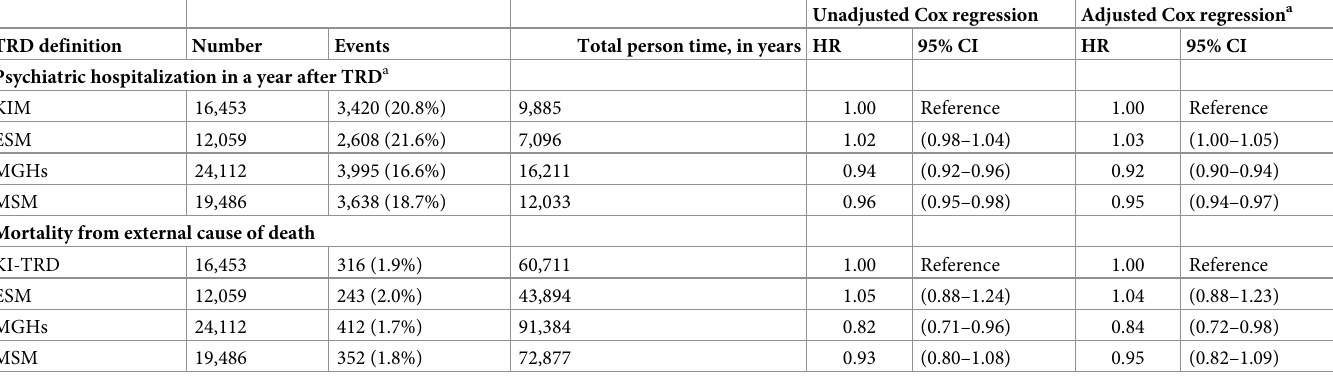
Table 2. Time to psychiatric hospitalization or death (external causes) comparing the Karolinska Institutet model (KIM) with the Massachusetts General Hospital Staging Method (MGH-s), the European Staging Method (ESM) and the Maudsley Staging Method